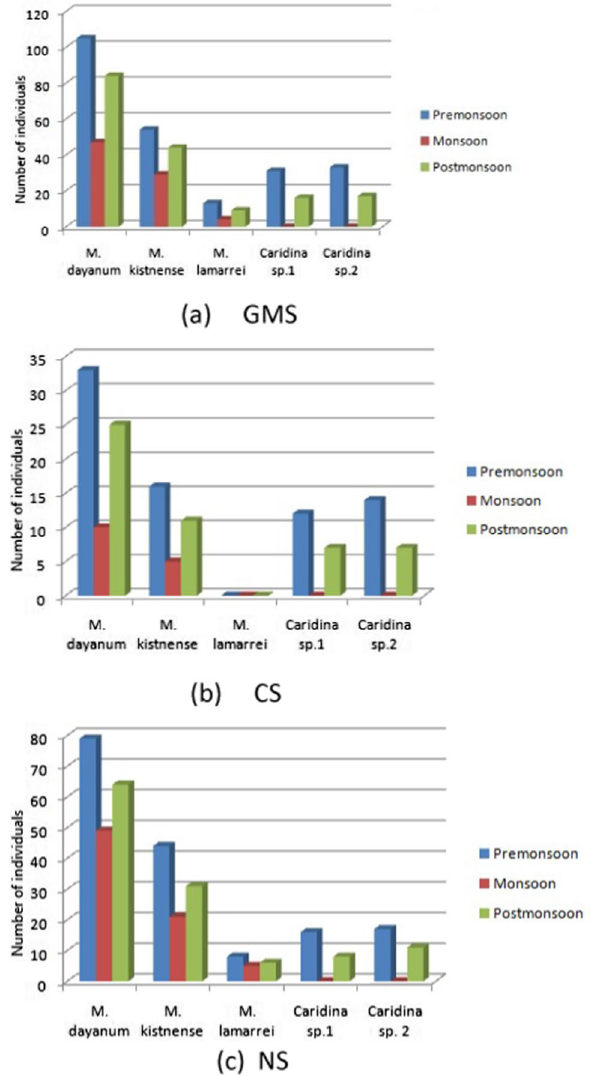
Fig. 3 Total abundance of prawn species during premonsoon, mon- soon and postmonsoon at three study sites